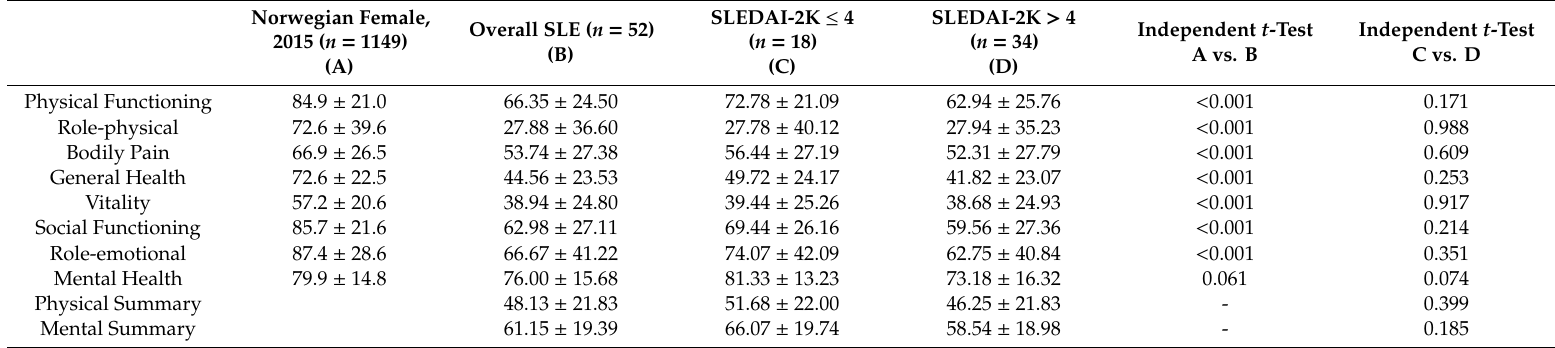
Table 2. Short Form Health Survey-36 (SF-36) Summary Measures and domain scores for (and within) patients in the Tromso Lupus Cohort against a Norwegian reference value from 2015. Figures indicate mean ± standard deviation.